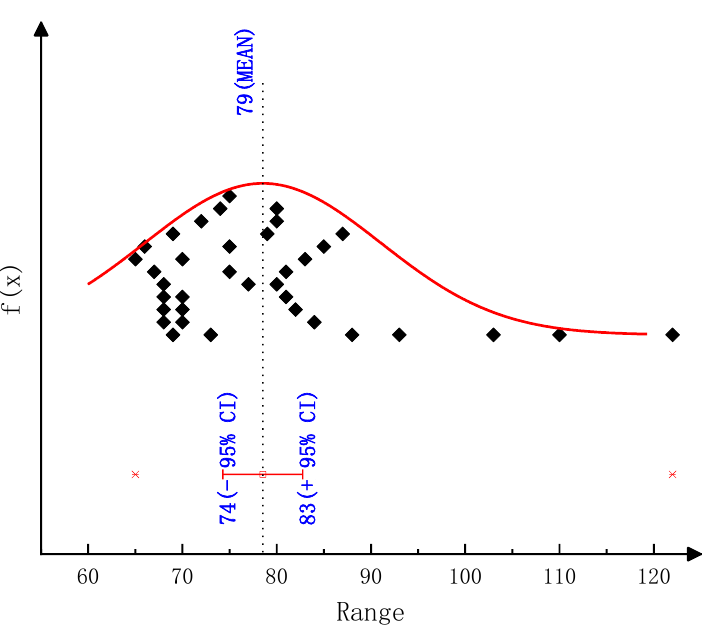
Figure A1. 95% confidence interval for the activation energy E O of urea pyrolysis reaction.